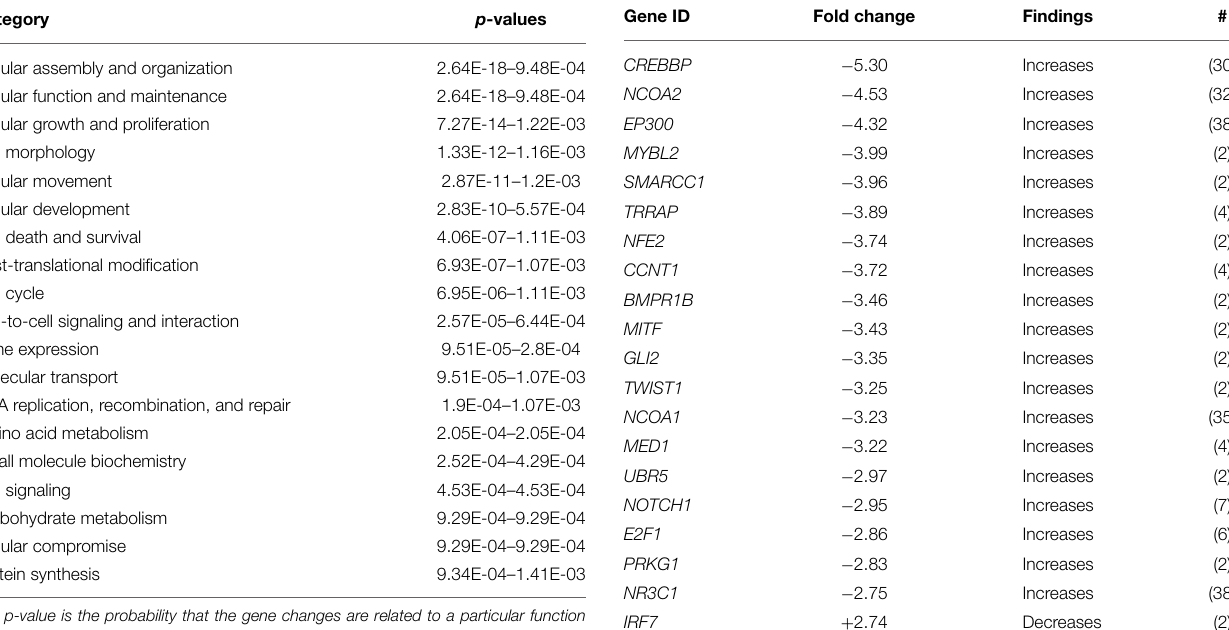
TABLE 3B | The 20 most genes regulated genes predicting a decrease in Transactivation between GD90 and GD165.